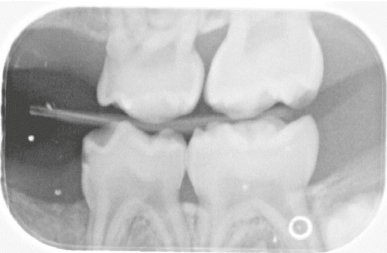
Figure 5: The radiograph demonstrates the absence of the max- illary and mandibular left primary canines.